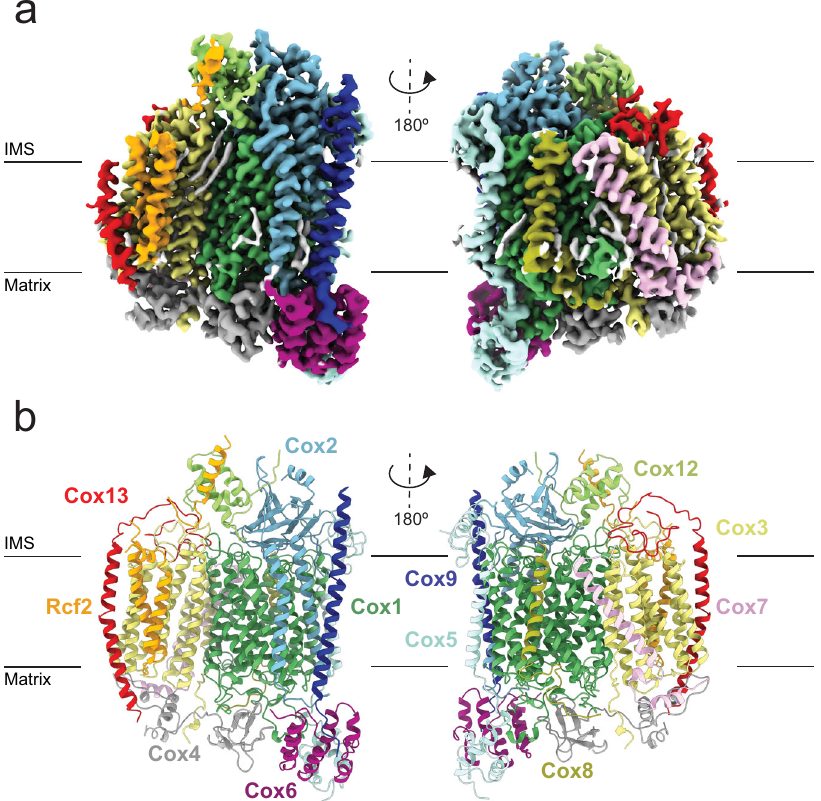
Fig. 1 Cryo-EM structure of the S. pombe CIV. The approximate position of the membrane is indicated, IMS denotes intermembrane space. a Cryo-EM map. b Atomic